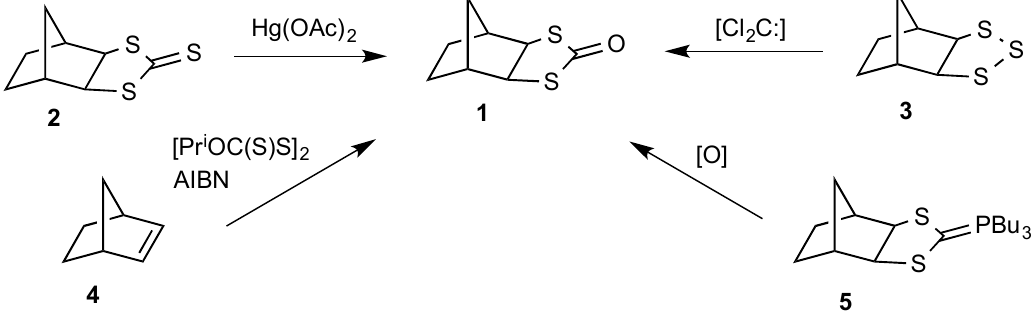
Scheme 1. Synthetic routes to 1.